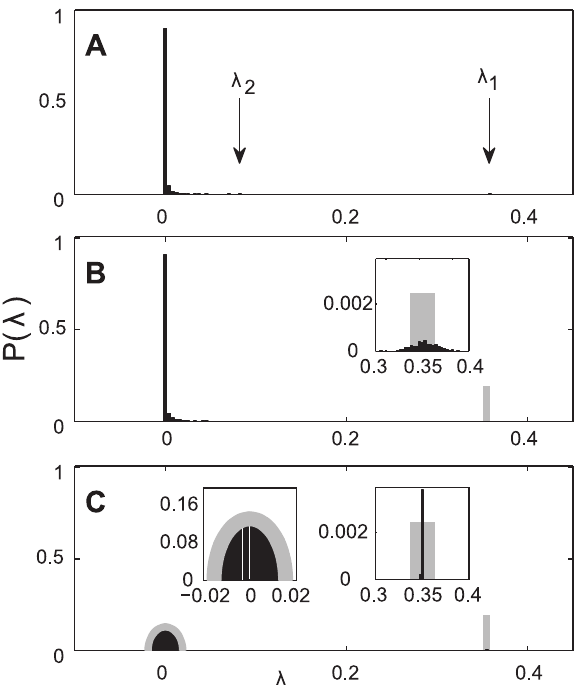
Figure 2. Spectra of the population covariance, sample covariance, and symmetric random matrices with matched element distribution. (A) Eigenvalue distribution of an example population covariance matrix C pop ( p ~ 256 ) computed from the van Hateren data set. The largest eigenvalue (marked with an arrow) corresponds to an eigenvector with only positive components, and is & 10 times larger than the second largest eigenvalue (also marked) and & 100 times larger than the mean eigenvalue. (B) Eigenvalue distribution of a collection of sample covariance matrices computed from stimuli randomly drawn from a multivariate Gaussian distribution N 0, C pop ð Þ . In gray is the analytic prediction for the outstanding eigenvalue. The spread of these eigenvalues (black, inset) is in agreement with the prediction in Eq. (8). (C) Eigenvalue distribution of symmetric random matrices with elements randomly drawn from a distribution given by the elements in the sample covariance matrices. In gray is the complete prediction (semicircle and outstanding eigenvalue) given by Eq. (5). Diagonal and off-diagonal elements are drawn separately from the distribution of matrix elements in panel